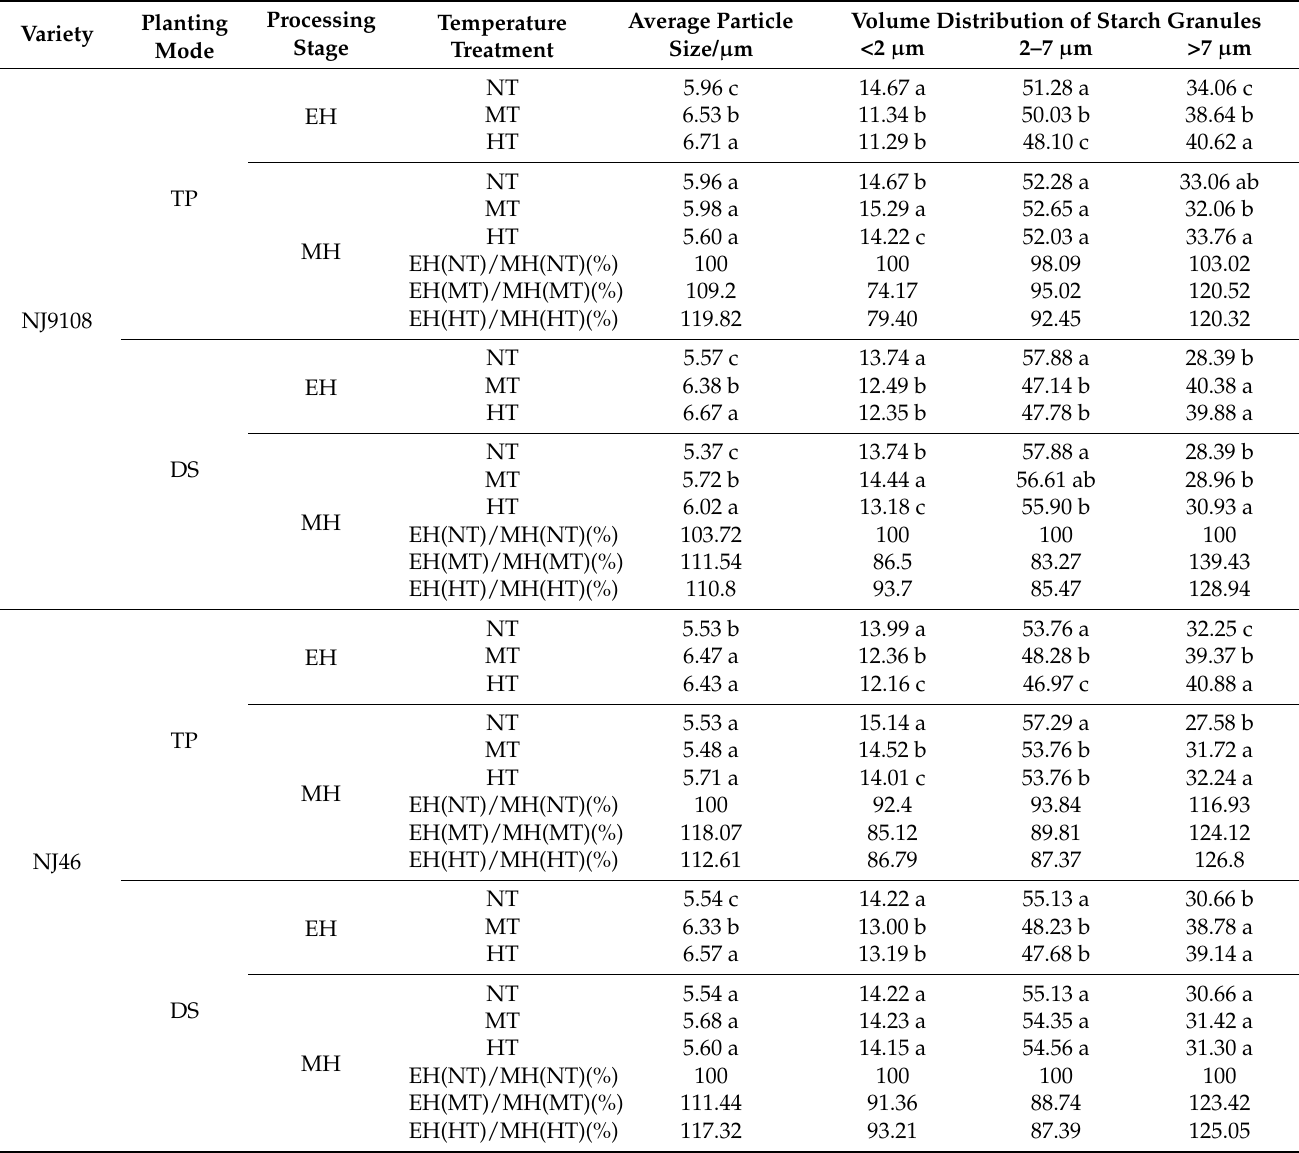
Table 7. Effects of high temperature on starch granularity of japonica rice in early and middle heading stage under transplanting and direct